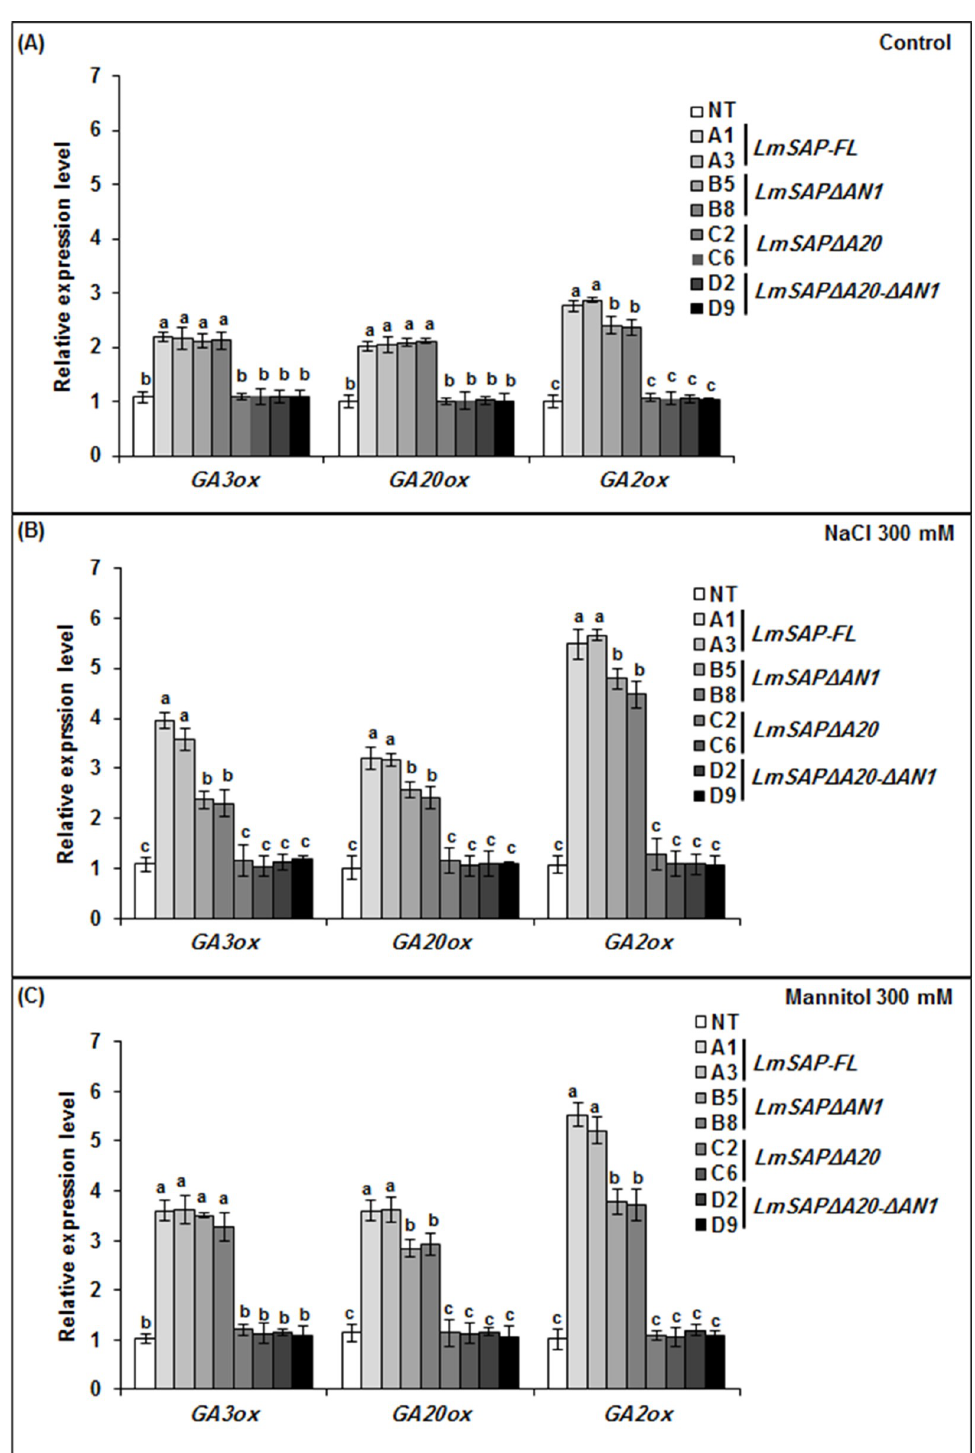
Fig 5. The mRNA level of GA3ox , GA2ox , and GA20ox genes examined by real-time PCR in LmSAP -overexpressing lines and non-transgenic (NT) plants grown on ( A ) MS medium (control), ( B ) MS medium supplemented with 300 mM NaCl , or ( C ) MS medium supplemented with 300 mM mannitol. Data represent the means ± SEM of three technical replicates. Means denoted by the same letter did not differ significantly at p < 0.05.